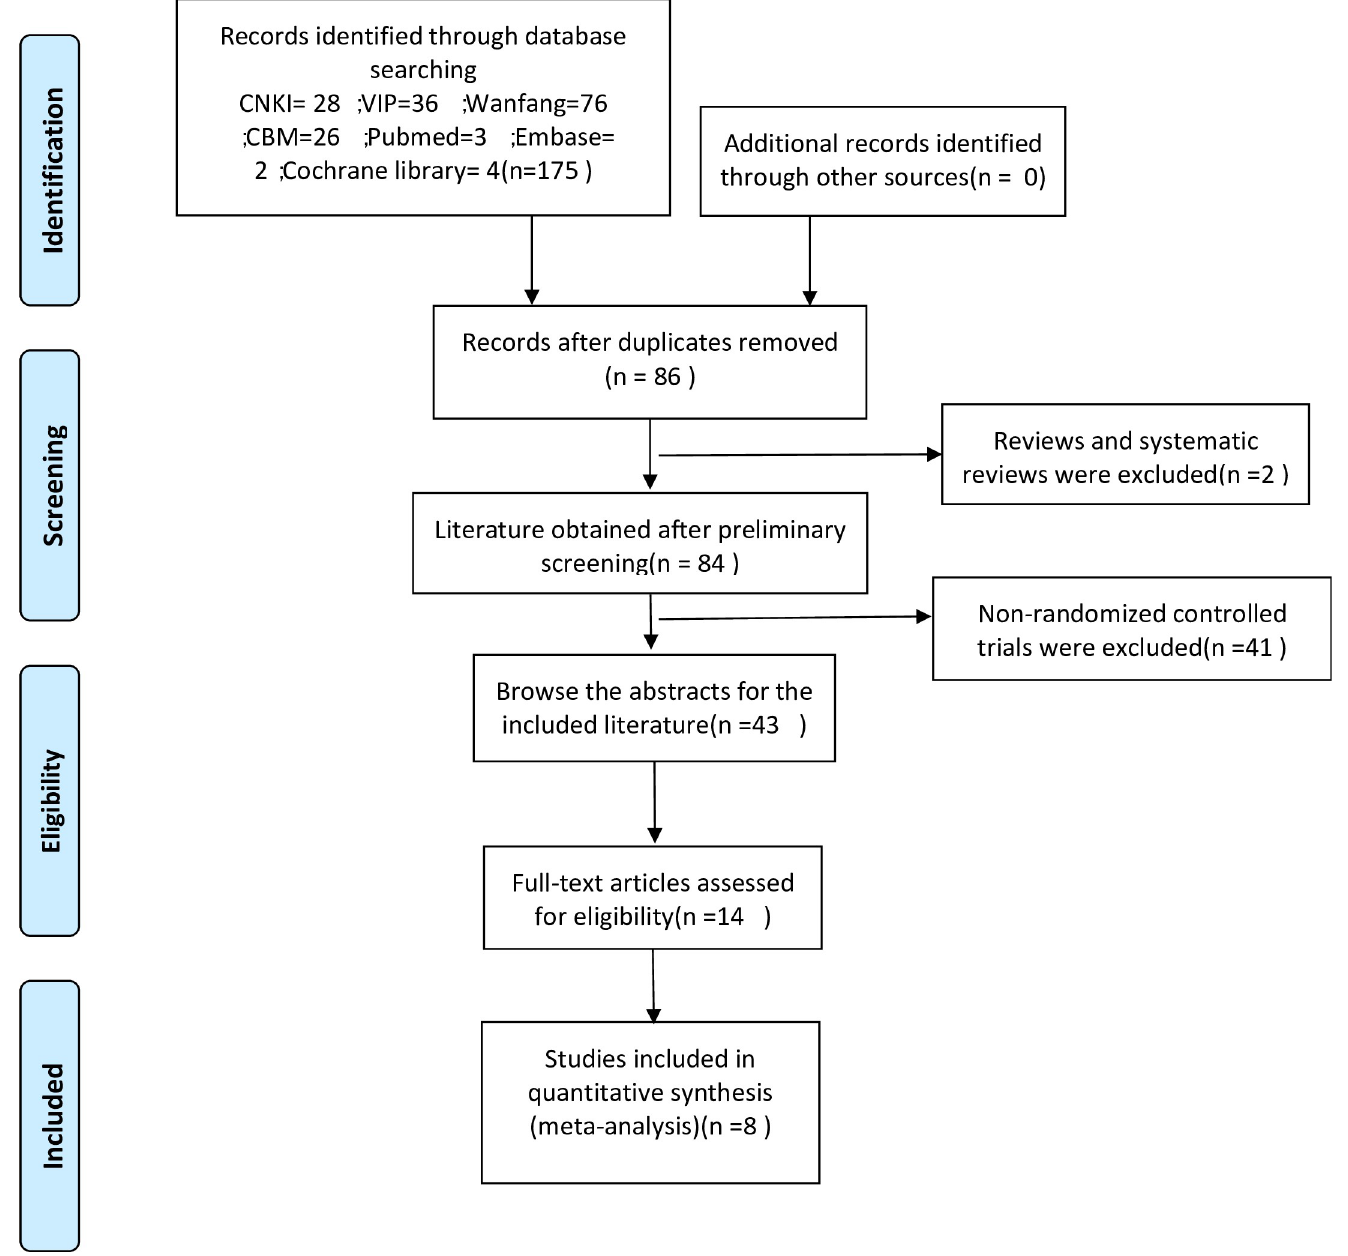
Fig 1. Flow diagram of the literature